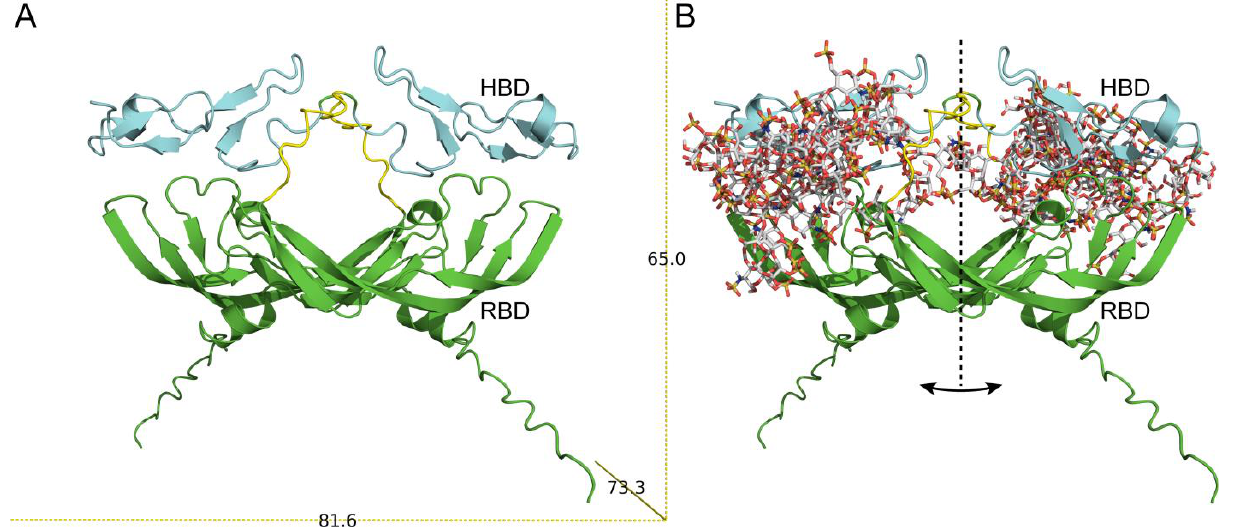
Figure 3. ( A ) The model of homodimeric VEGF 165 . RBD and HBD domains are highlighted by green and cyan, respectively; ( B ) Overlay of the 25 representative models of the VEGF 165 – HE complexes calculated using ClusPro docking server [44]. HE is shown in the stick representation.